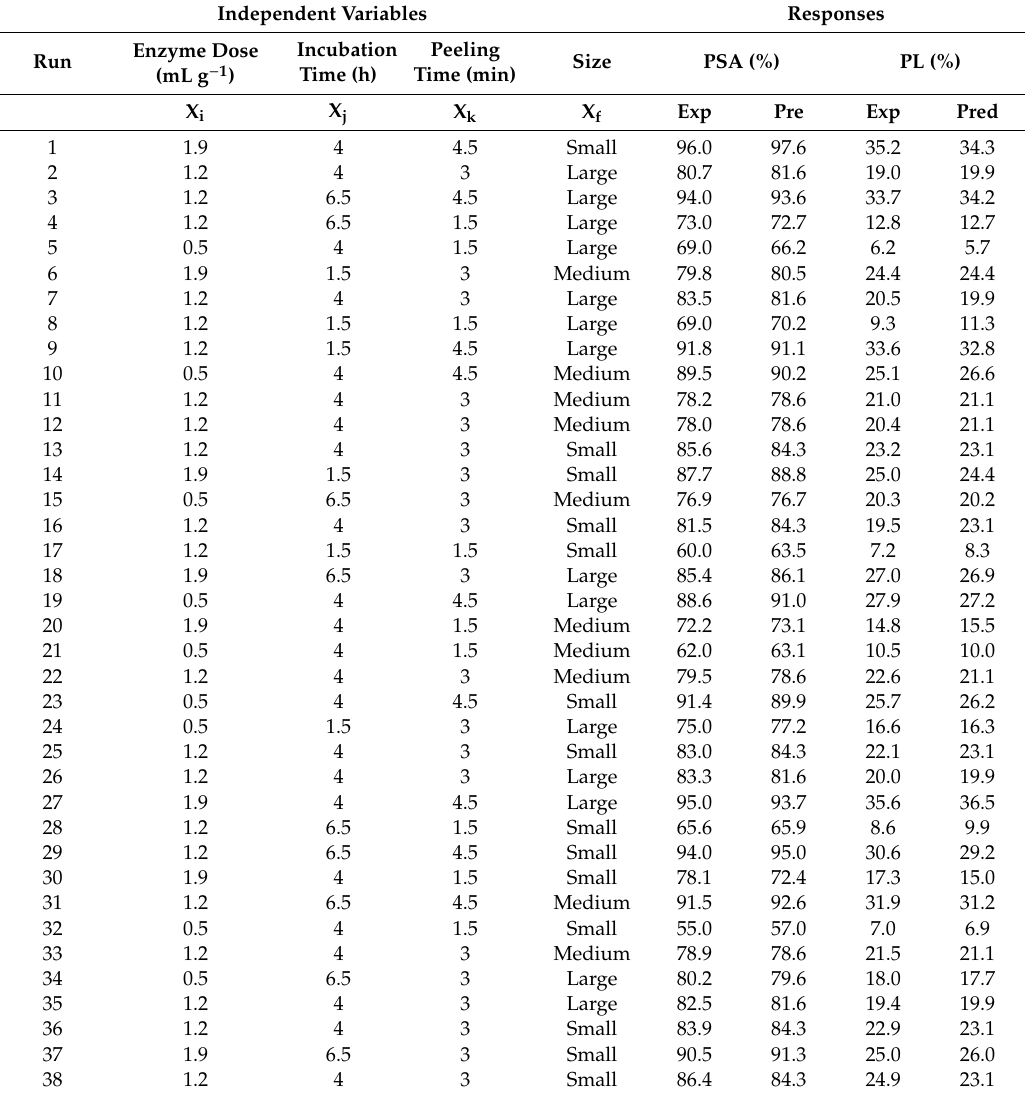
Table 2. Design matrix of response surface methodology (RSM) and experimental (EXP) and predicted (Pred) values for peeled surface area (PSA) and peel loss (PL) of enzyme treated cassava tubers after mechanical